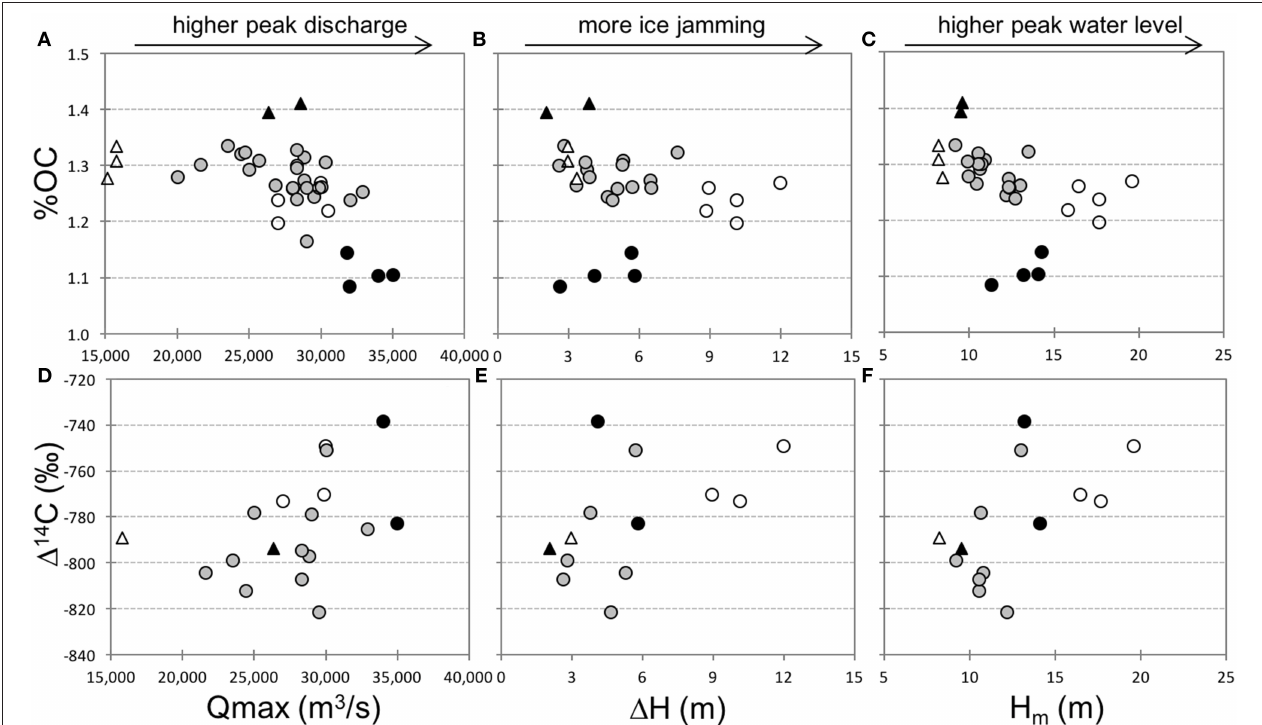
FIGURE 10 | Hydrological controls on bulk %OC and 14 C-OC content of lake LD-1 downcore sediments, using hydrological data from 1974 to 2009 from Goulding et al. (2009), including (upper): %OC plotted against (A) Q max , (B) 1 H, (C) H m , and (lower) 1 14 C ( ‰ ) plotted against (D) Q max , (E) 1 H, and (F) H m . Q max is defined as the maximum break-up discharge (m 3 /s), 1 H as the backwater level, indicating the difference in height between ice-affected stage and height at equivalent discharge under open water conditions (m), and H m is the maximum peak water level during break-up (m). Years with high discharge and moderate 1 H and H m are plotted as black circles, years with moderate discharge but high 1 H and H m are plotted as white circles, years with low discharge, low 1 H, and low H m are plotted as white triangles, and year(s) with moderate discharge, and low 1 H and H m are plotted as black triangles. The gray circles show all other years. Note that (D–F) have fewer data points as we do not have 14 C data for all